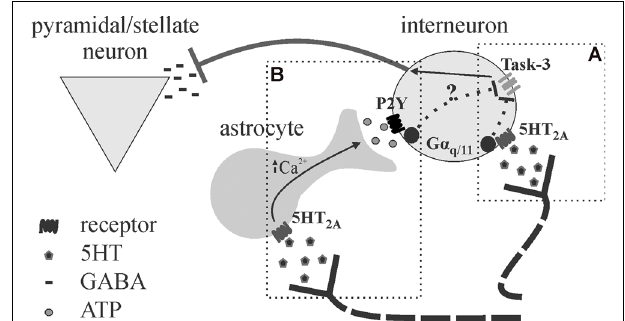
FIGURE 5 | Proposed schematic for astrocytes as intermediary or amplifier of 5HT-mediated inhibition. (A) Deng and Lei (2008) show 5HT effects on inhibition in the auditory cortex are mediated by 5HT 2A receptors, G α q/11 , and task-3 potassium channel inhibition. (B) We recently provided evidence that astrocytes may be an intermediary in the effects of 5HT on cortical inhibition in the somatosensory cortex (Quon et al., 2018; Wotton et al., 2018), as the application of purinergic antagonists and disruption of astrocytic metabolism blocked the effects of 5HT. It appears possible that 5HT promotes astrocytic ATP release downstream of 5HT2A stimulation, leading to interneuron depolarization (P2Y also linked to G α q/11 ). It is not clear whether astrocytes mediate 5HT effects entirely or merely serve to amplify the effects given their strategic position.